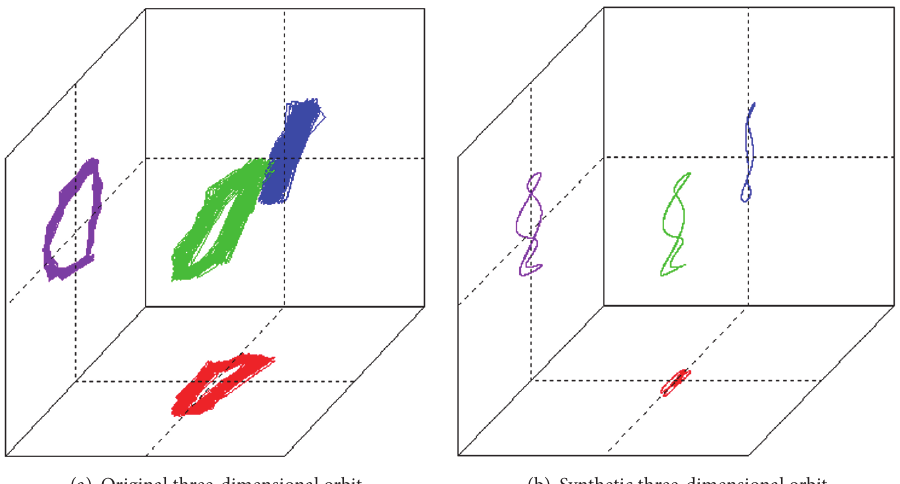
Figure 7: Original and synthetic three-dimensional spatial orbit.